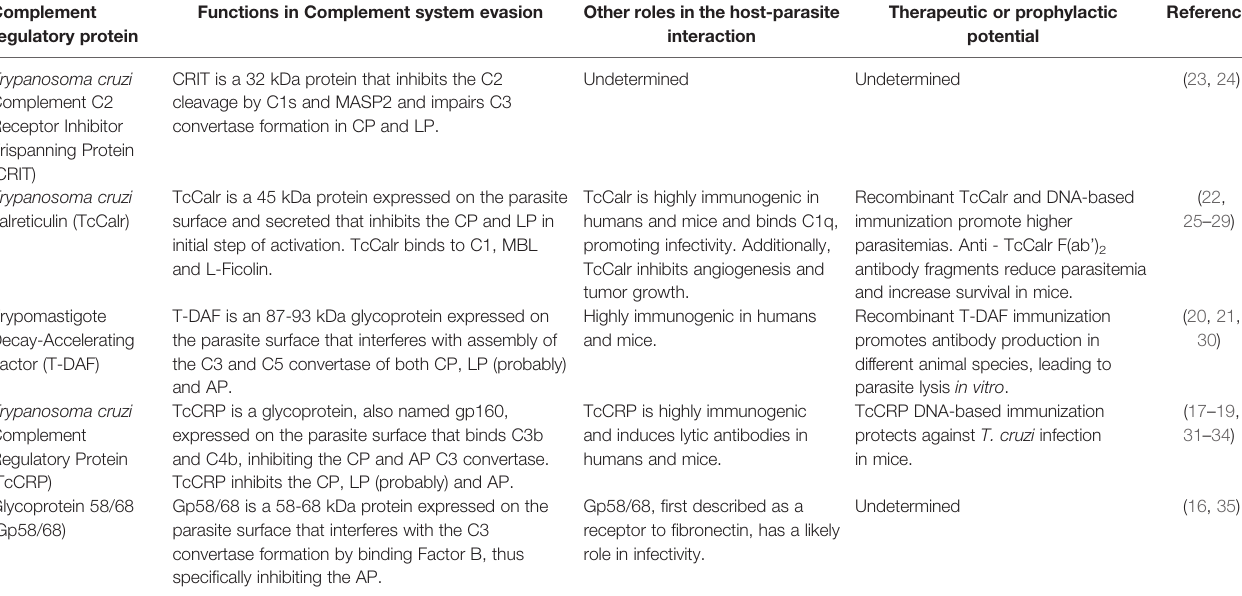
TABLE 1 | Complement regulatory proteins expressed and/or secreted by Trypanosoma cruzi , their roles in the host-parasite interaction and as potential therapeutic or prophylactic tools. Complement regulatory